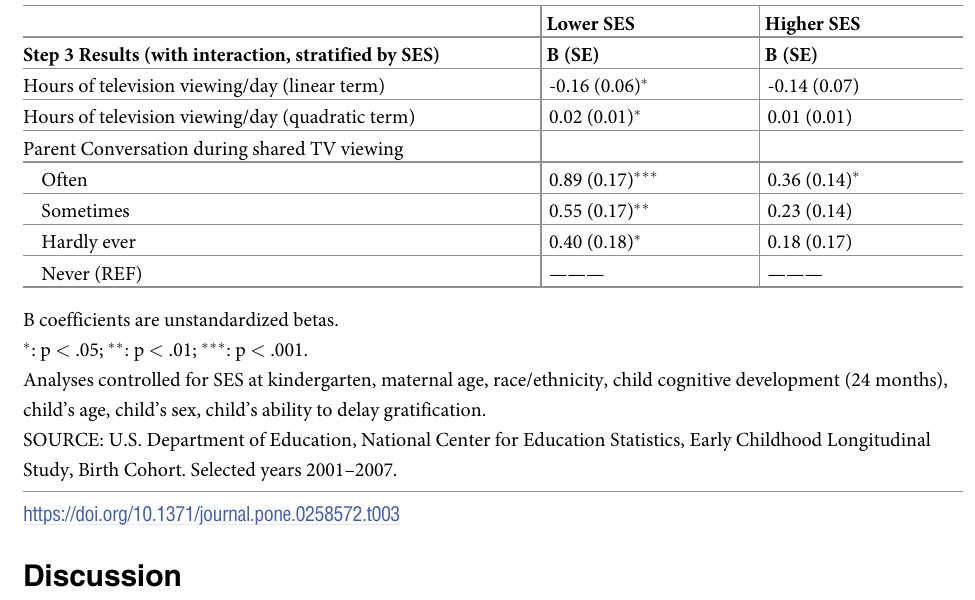
Table 3. Adjusted associations of daily television viewing, parent conversation during shared television viewing and curiosity at kindergarten, stratified by higher and lower socioeconomic status (SES). Lower SES Higher SES Step 3 Results (with interaction, stratified by SES) Hours of television viewing/day (linear term)